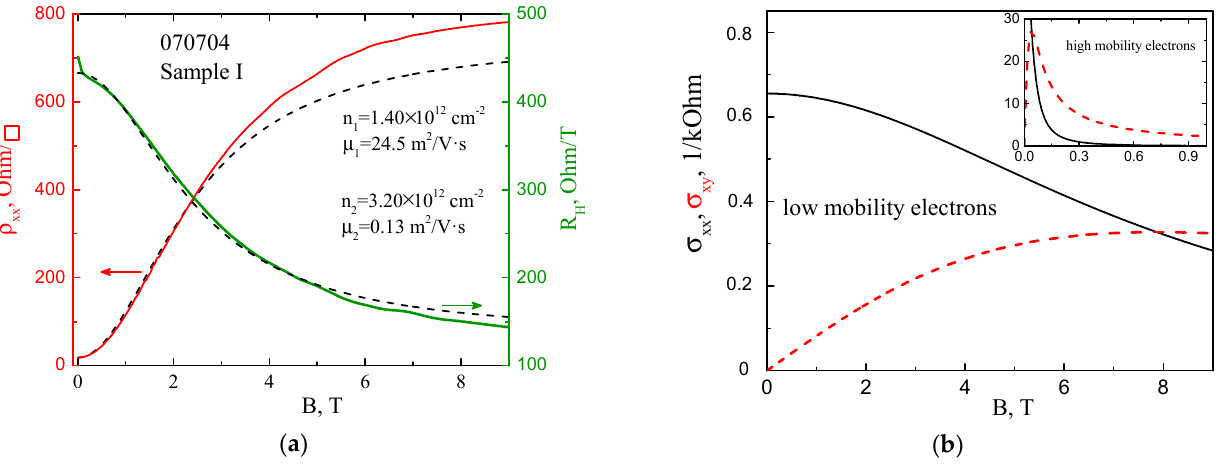
Figure A1. ( a ) Dependences of the monotonous part of ρ xx and Hall constant, R H , on magnetic field B (solid lines) for Sample I and their fitting by Equation (A2) (dash lines). The resulting fitting procedure parameters are also displayed. ( b ) Dependences of σ xx (solid lines) and σ xy (dash lines) on magnetic field B for the low-mobility and high-mobility (inset) electrons, plotted with Equation (A1) using parameters from fitting procedure (Figure A1a).